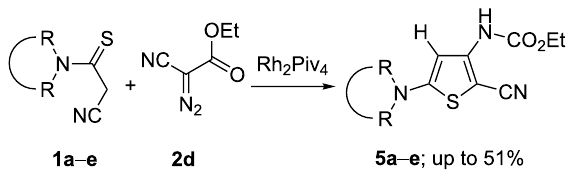
the range of 9.84–9.68 and 7.96–7.80 ppm for 3a – e and 4a – e ,